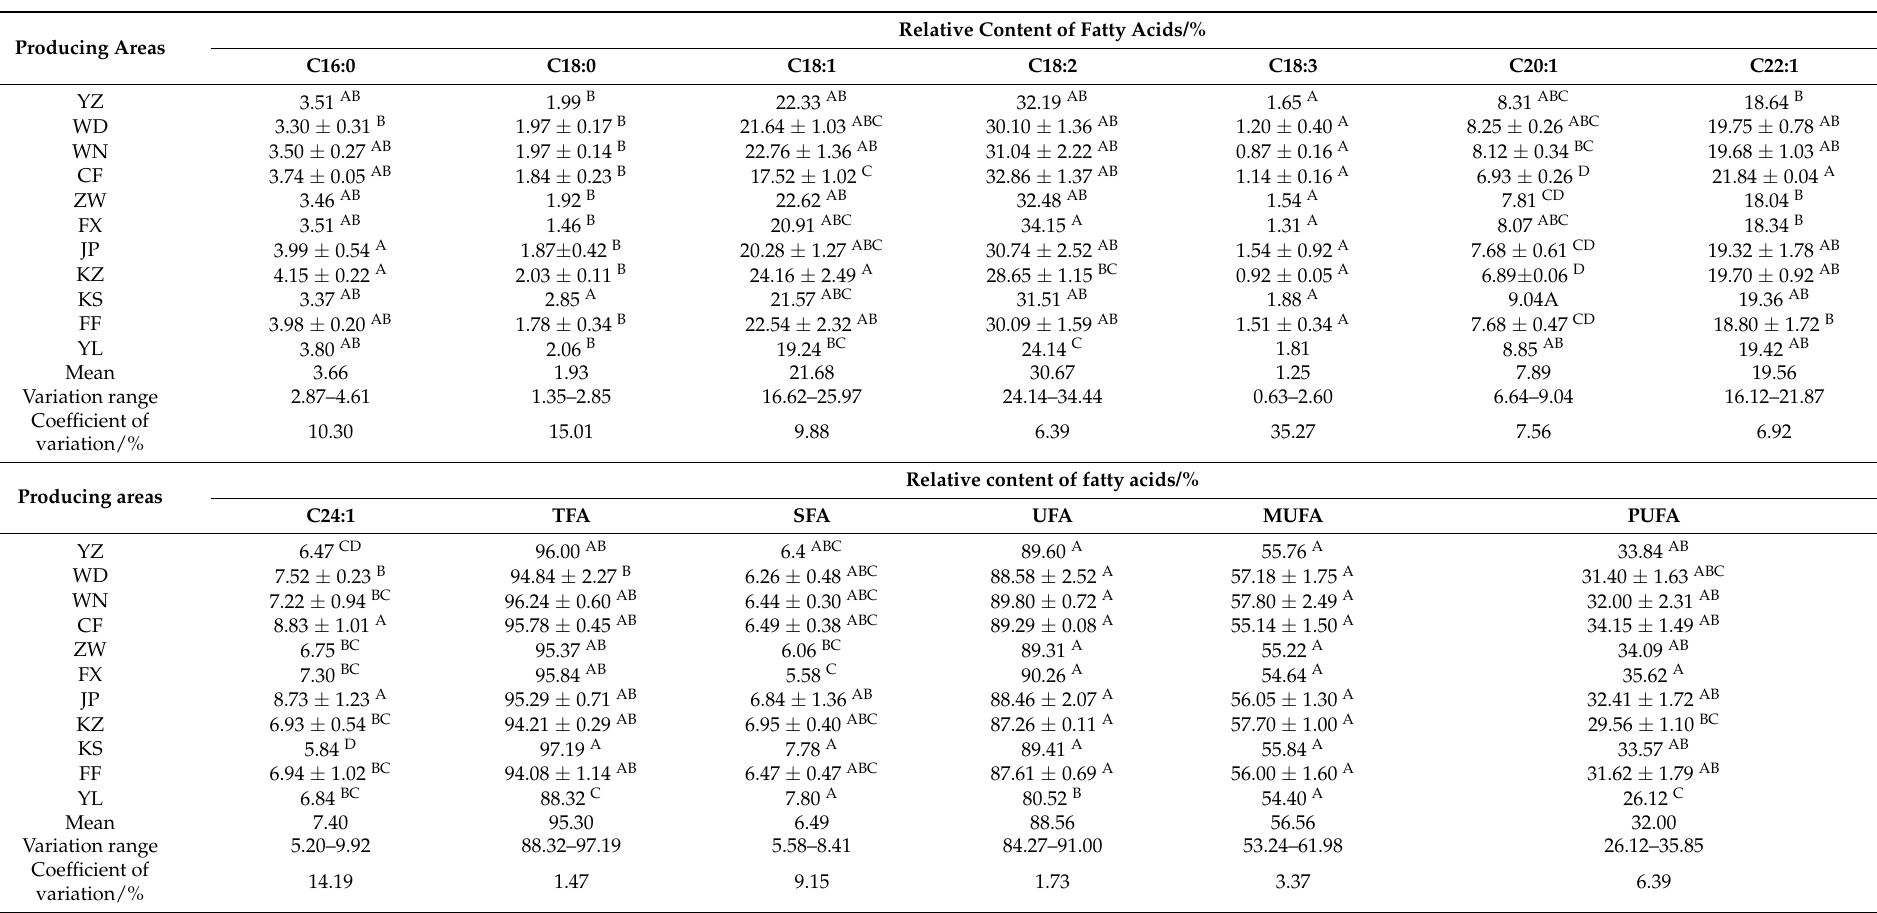
Table 3. Relative content of main fatty acids in kernel oil of A. truncatum from different producing areas. The natural forest production areas: Horqin Right Wing Middle Banner (YZ), Wudantala Forest Farm (WD), Wengniuteqi Pine mountain Forest Farm (WN) and Chifeng city (CF) of Inner Mongolia, Zhangwu (ZW), Fuxin (FX), Jianping (JP) and Kazuo (KZ) city of Liaoning, Kashi (KS) city of Xinjiang, Fufeng (FF) and Yangling (YL) city of